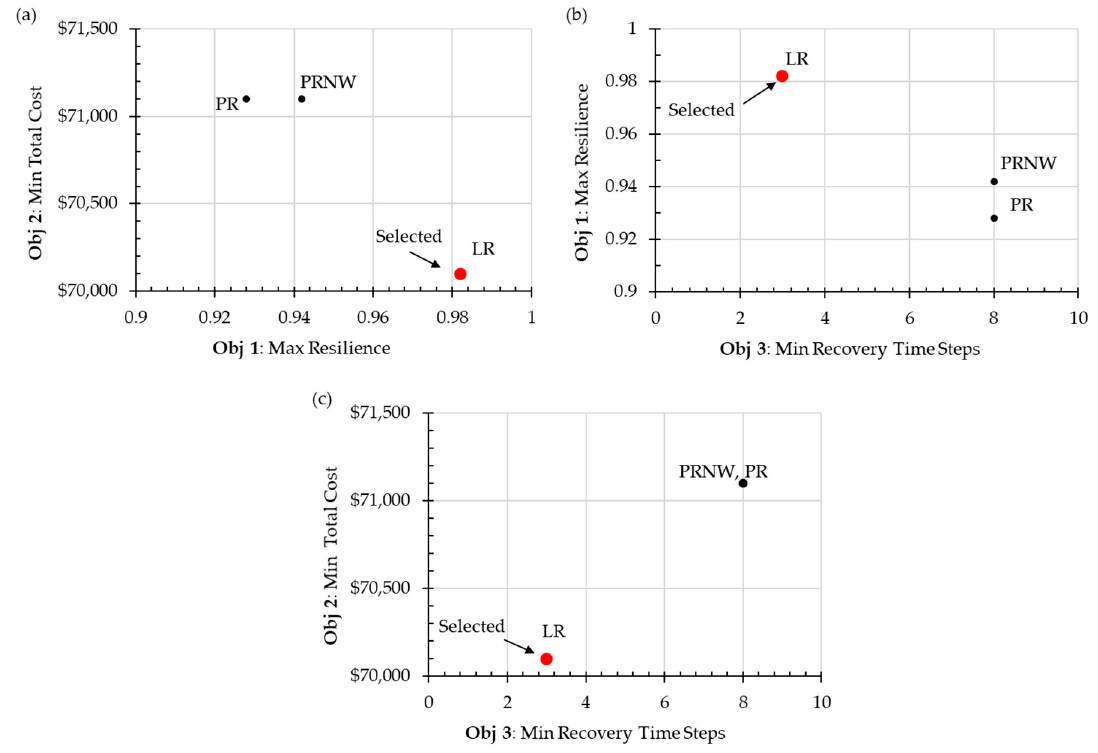
Figure 8. Objective trade-offs between ( a ) total recovery cost and resilience, ( b ) total recovery cost and recovery time steps, and ( c ) resilience and recovery time steps.